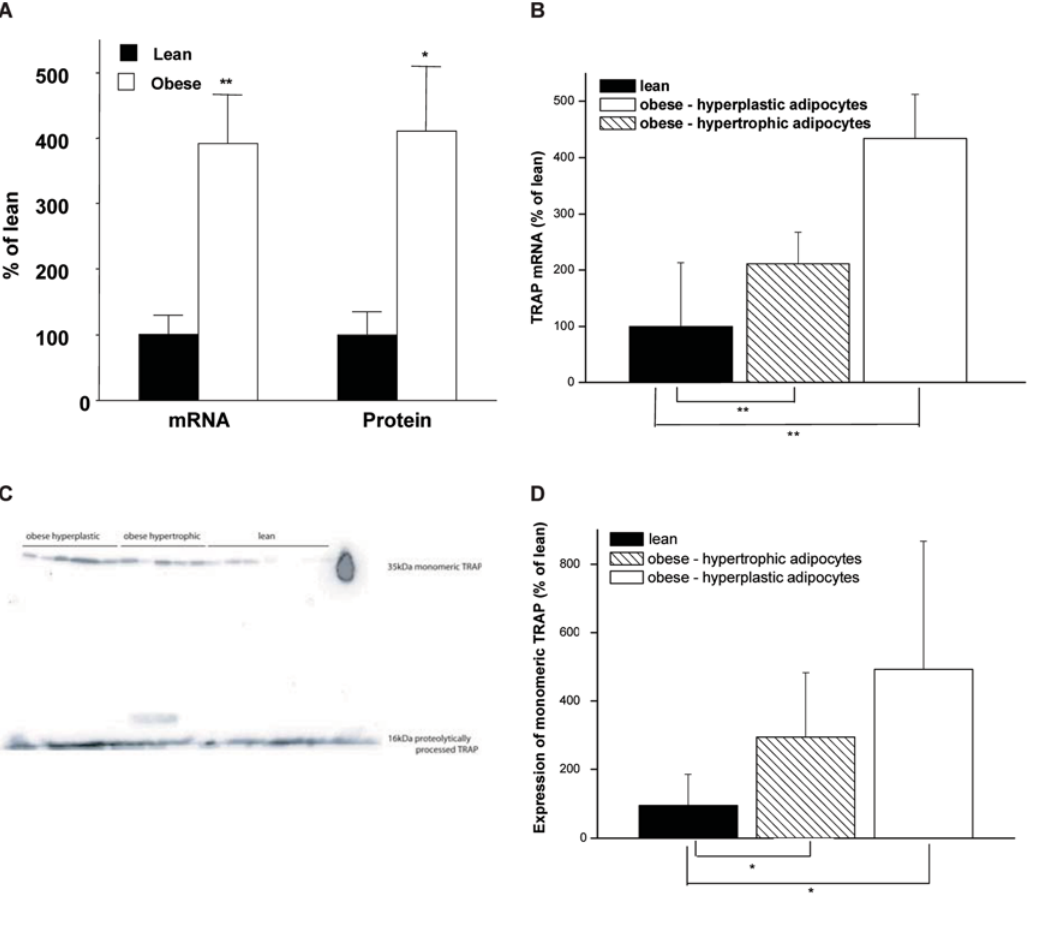
Figure 3. Expression of TRAP mRNA and protein in human adipose tissue. (A) Expression of TRAP mRNA and monomeric TRAP protein in obesity compared to the lean state. (B) TRAP mRNA, (C) total TRAP protein and (D) monomeric TRAP protein expression in hyperplastic and hypertrophic obesity.